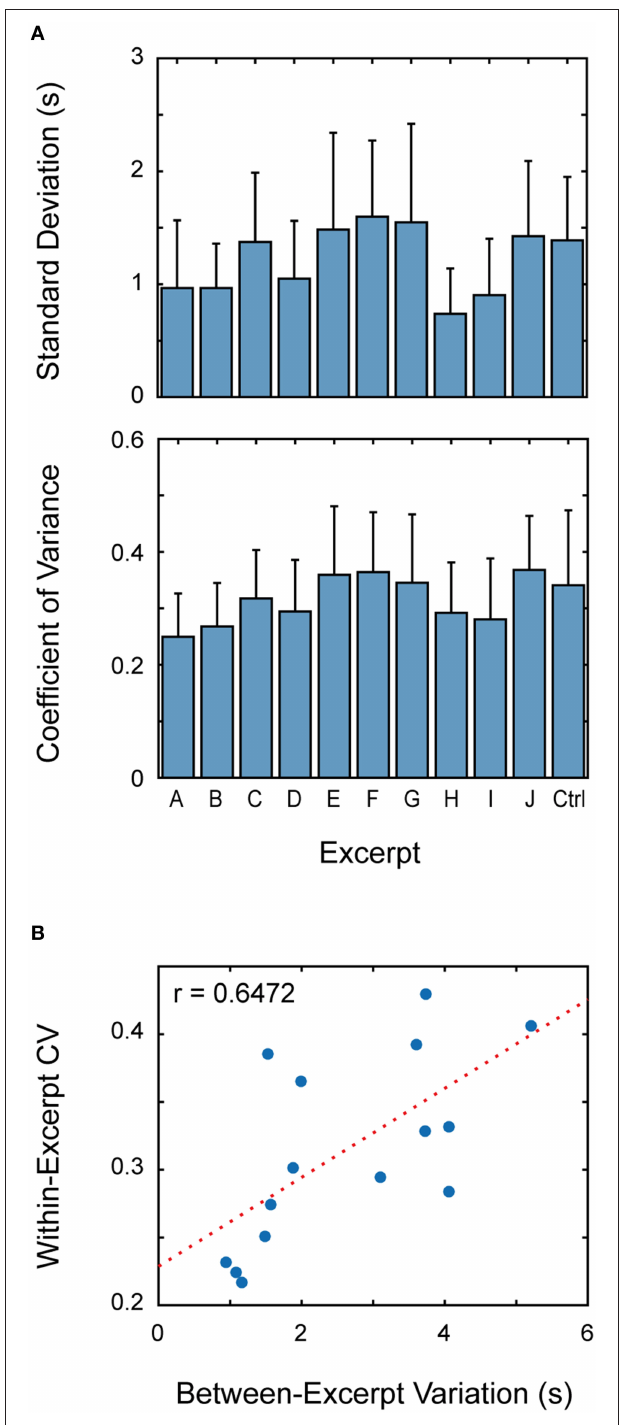
FIGURE 4 | Fluctuation of expiration intervals. (A) The upper panel shows the inter-participant averages of standard deviation of breath intervals within music excerpts, and the lower panel shows those of coefficient of variation (CV). Both standard deviation and CV value significant differed between the excerpts. (B) The relationship between the variation of breath interval between different music pieces and that CV value within music pieces is plotted. There is positive correlation between these